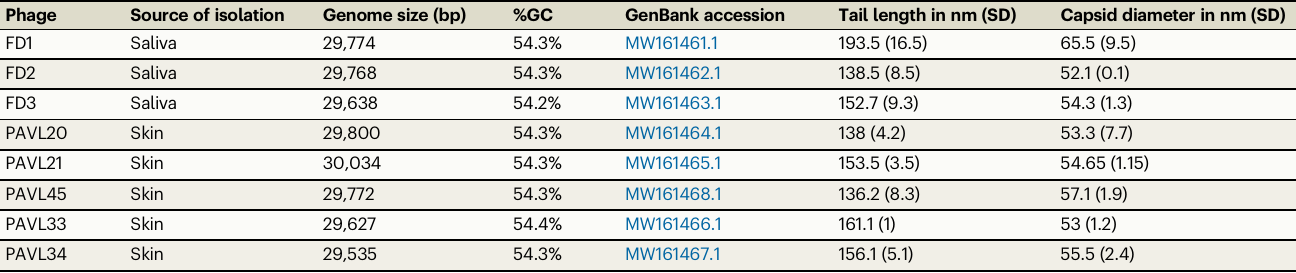
Table 2 | Characterization of the isolated Cutibacterium acnes phages Phage Source of